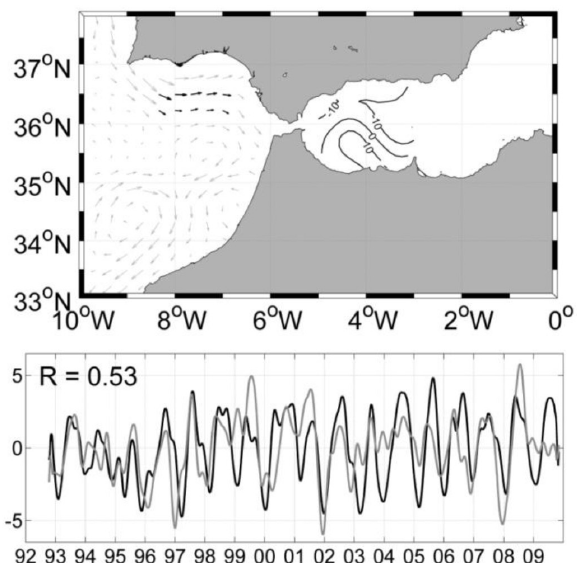
f iG . 7. – Upper panel: map showing the grid points (black arrows) used to average the velocity used as a proxy of time variability in the GoC. Lower panel: time series of this averaged velocity (black line) represents time series of previous features for GoC and sea level differences for AS (lighter colour), in which fluctuations below two months and their means have been removed. The degree of correla- tion is